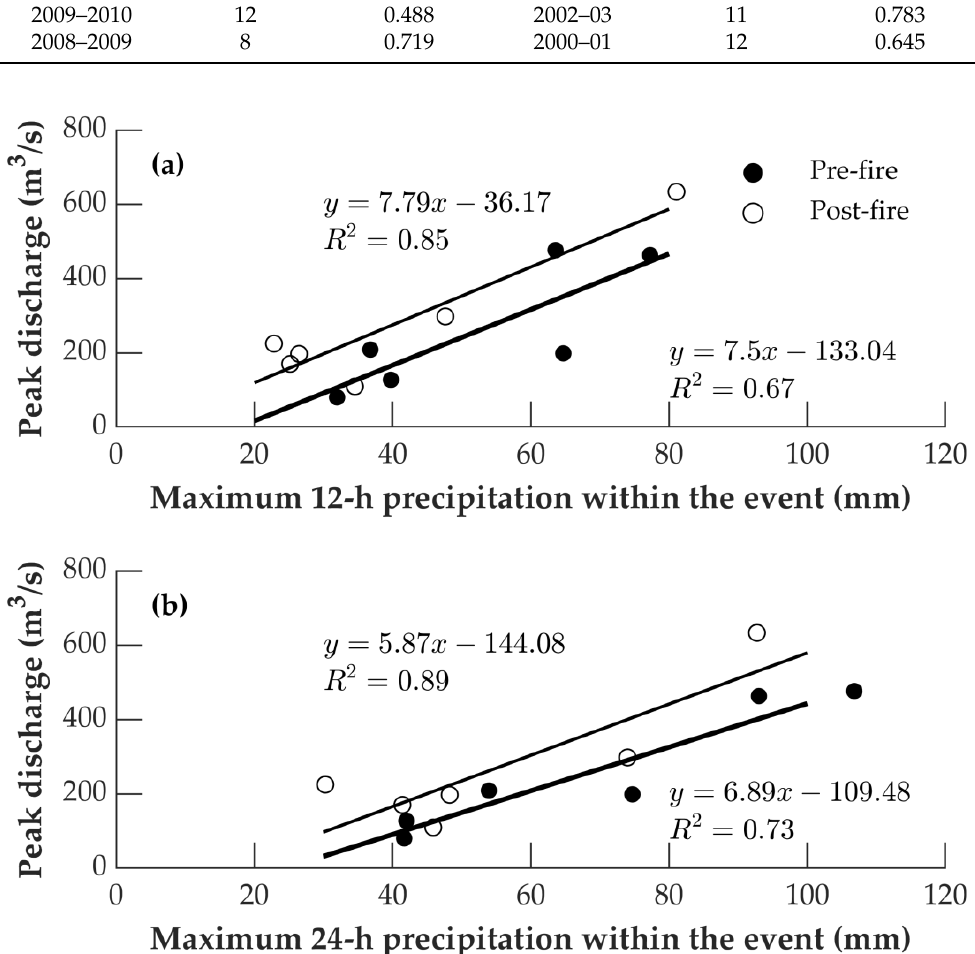
Figure 6. Comparison of ( a ) 12-h and ( b ) 24-h maximum rainfall depth and the observed peak flow within the event.